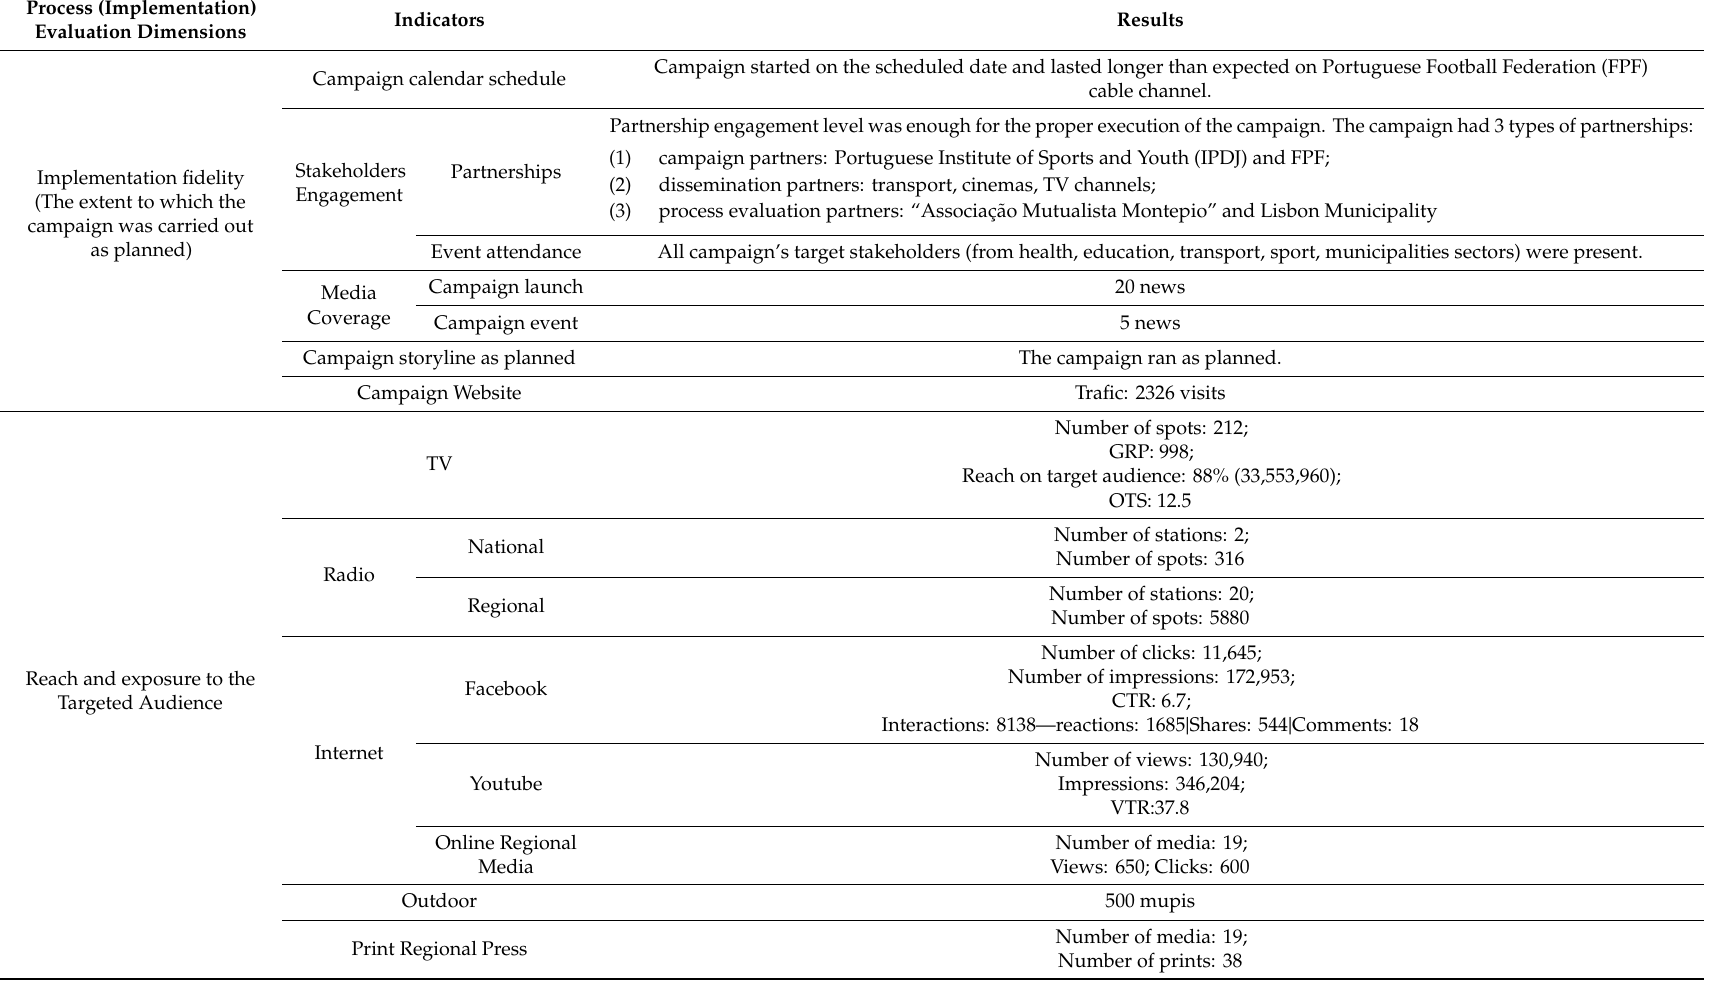
Table 1. Process evaluation dimensions and